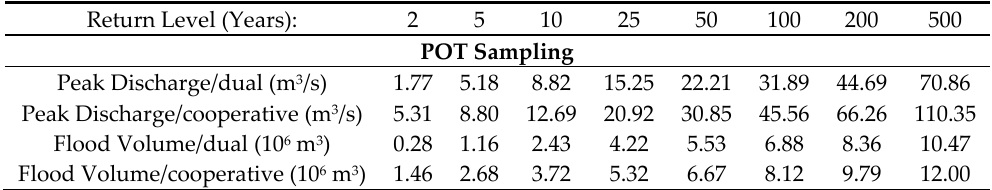
Table 3. Results of the Bivariate Return Periods 2, 5, 10, 25, 50, 100, 200 and 500 for Peak Discharge and Flood Volume using Peaks over Threshold (POT)